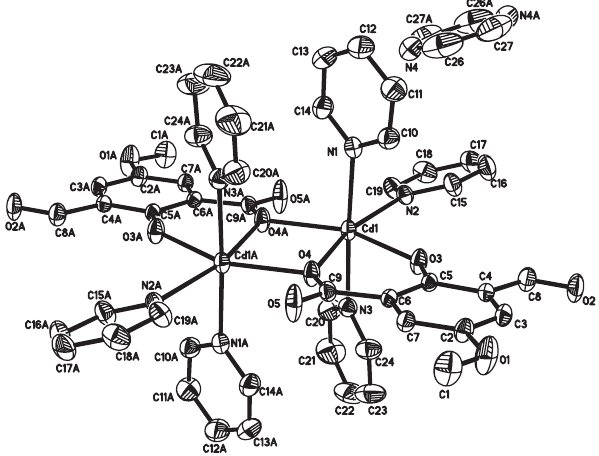
Table 1: Data collection and